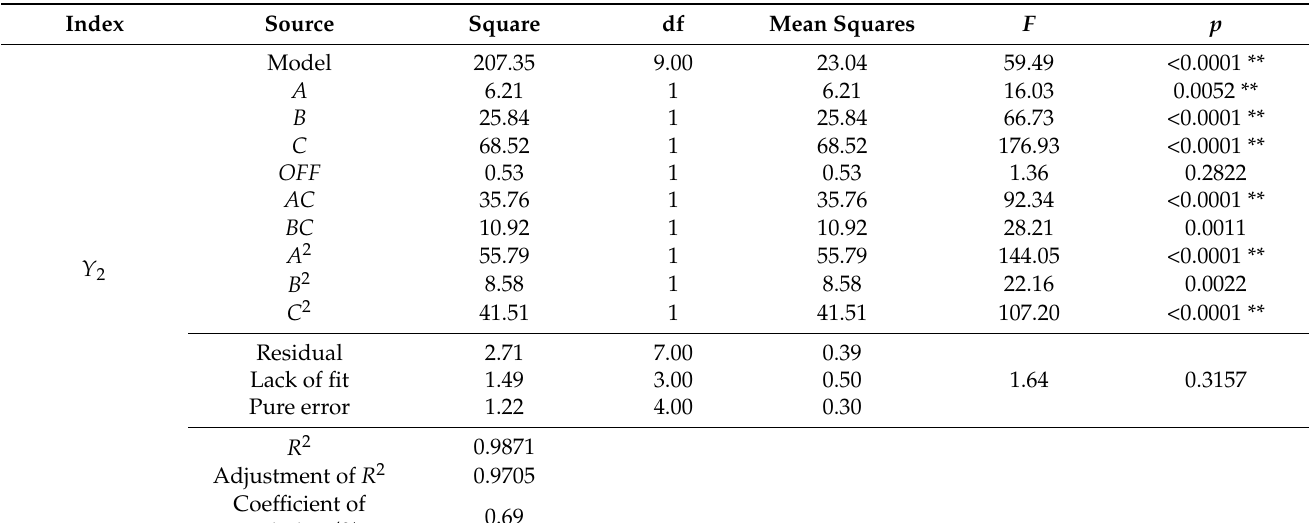
Table 4. Variance analysis of pass rate.